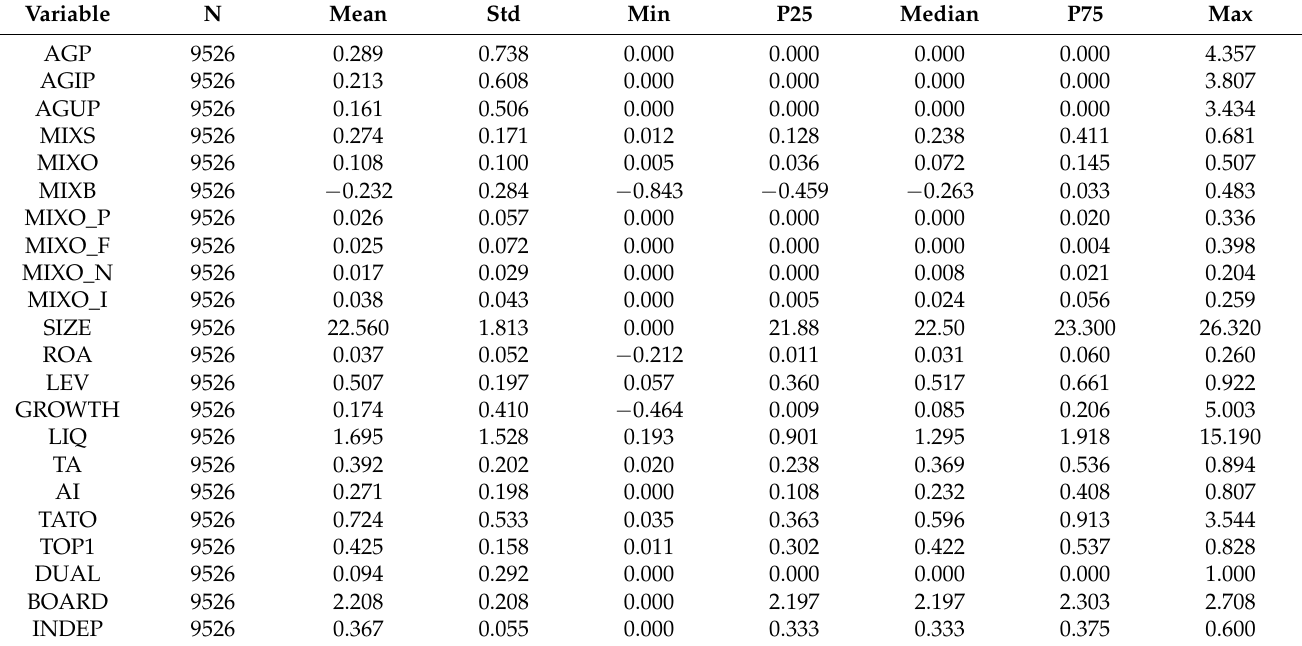
Table 2. Summary